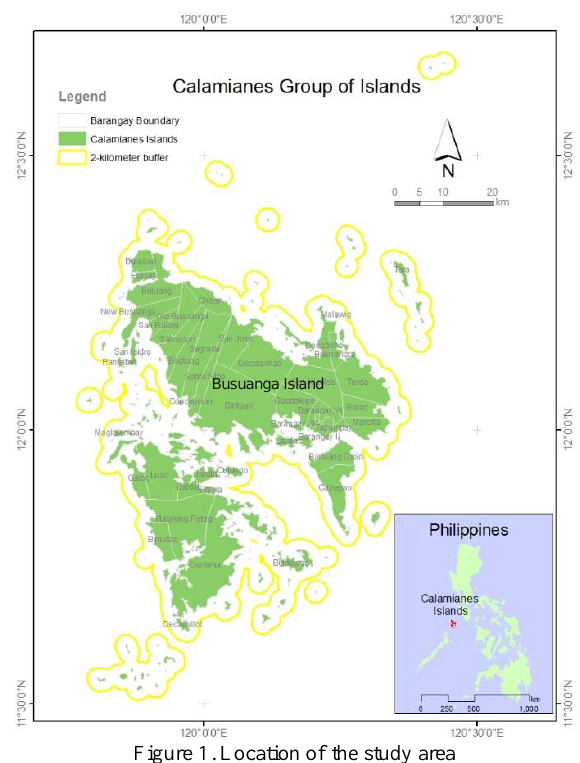
Figure 1. Location of the study